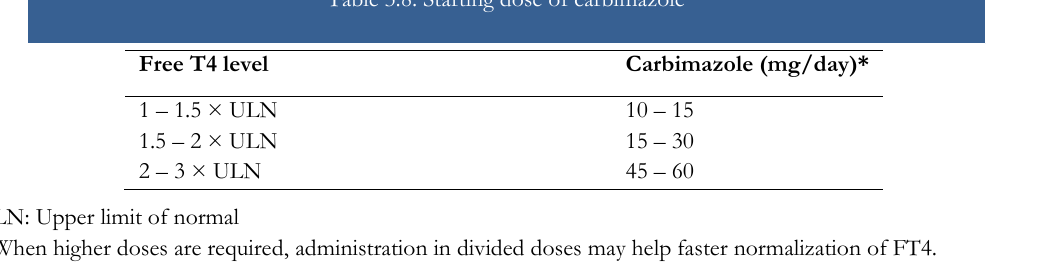
Table 3.8. Starting dose of carbimazole